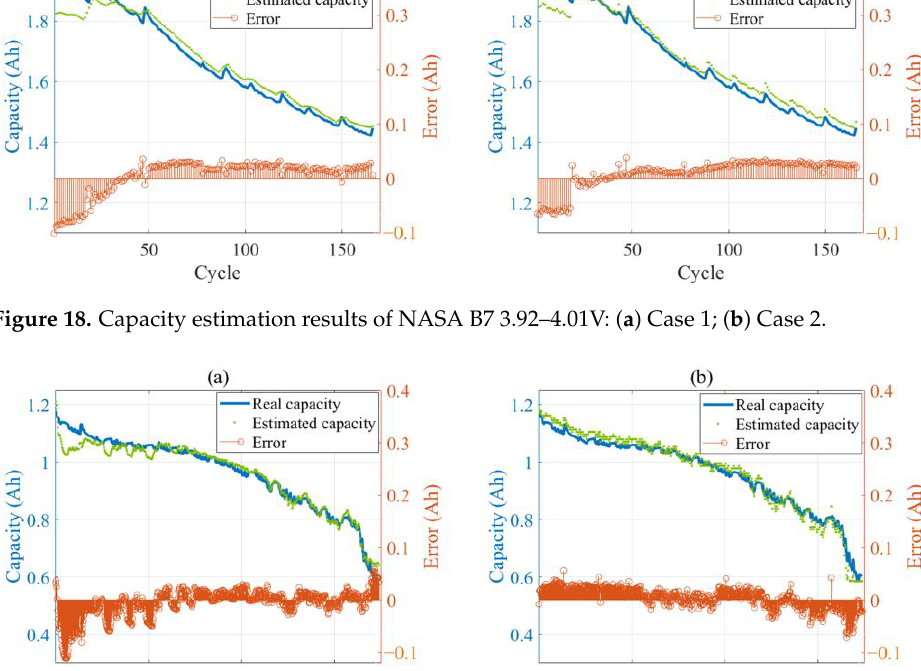
Figure 20. Capacity estimation results of CALCE CS37 3.85 – 3.98 V: ( a ) Case 1; ( b ) Case 2.